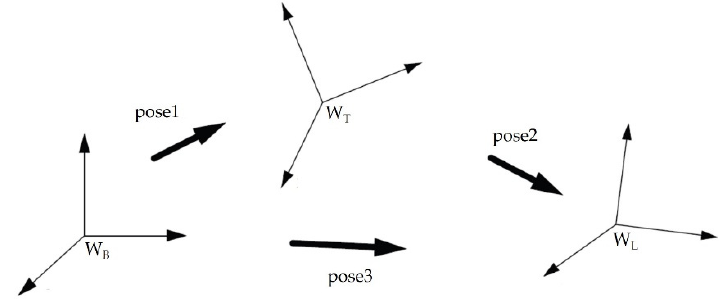
Figure 9. The idea behind the PoseMult